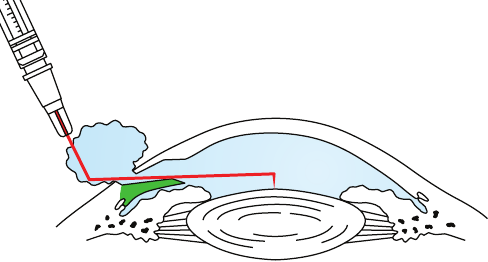
(b) Schematic diagram of 2-bend cystotome: the conventional 2-bend cystotome has one straight arm only, which inevitably presses the posterior lip when performing a CCC, allowing the viscoelastic agent to escape and failing to sustain the ACD Figure 2: Schematic diagram of 3- and 2-bend